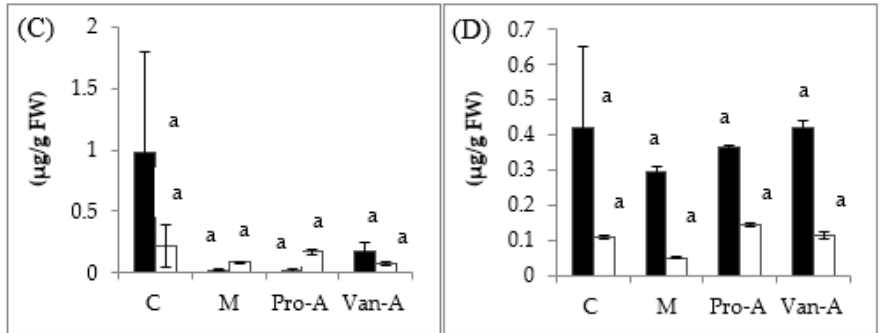
Figure 2. Variation of: total phenolic ( A ); total flavonoid ( B ); protocatechuic acid ( C ); and vanillic acid ( D ) contents in rice after pre-treatment with PA and VA. Black column (leaves) and white column (roots). Means with different small letters in the same column color are significantly different ( p < 0.05); FW: Fresh weight, GAE: Gallic acid equivalent, RE: Rutin equivalent.